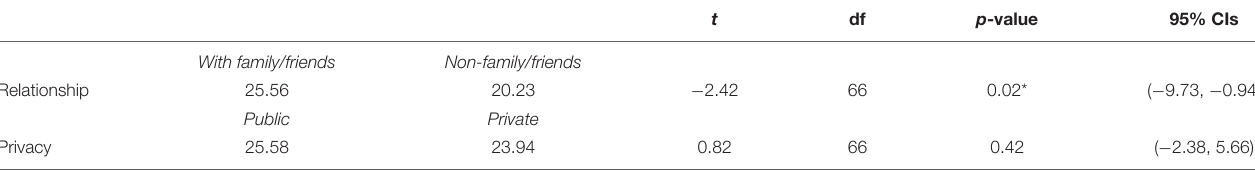
TABLE 5 | T -tests of meaningfulness by relationship to person/people and privacy level.